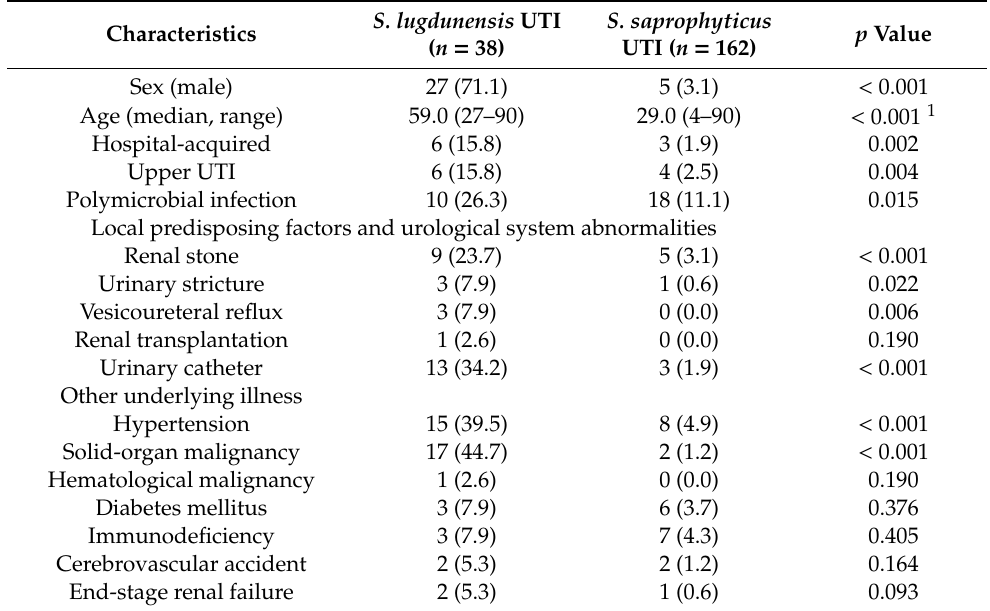
Table 1. Clinical characteristics of S. lugdunensis and S. saprophyticus urinary tract infection. Characteristics